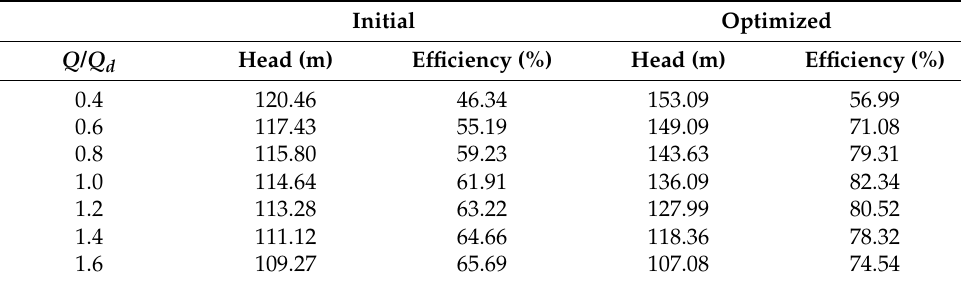
Table 10. The results of surface response optimization.